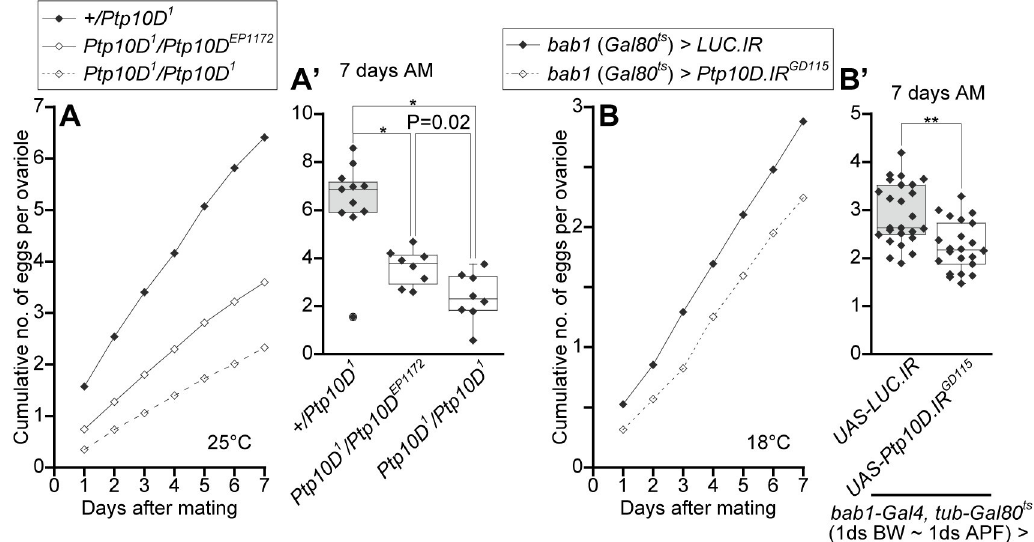
Fig 6. Loss of Ptp10D diminishes the efficient egg production. (A and B) Line graphs represent means of cumulative numbers of eggs per ovarioles laid by single females after mating with single wild-type Canton-S males. (A) Data values from control +/Ptp10D 1 (black line and closed dots in A), Ptp10D 1 /Ptp10D EP1172 (black line and open dots in A), and Ptp10D 1 /Ptp10D 1 (dashed line and open dots in A) at 25 degrees. (B) Data values from control UAS-LUC . IR (black line and closed dots in B) and UAS-Ptp10D . IR (dashed line and open dots in B) by bab1-Gal4 /TARGET at 18 degrees. (A’ and B’) Boxplots overlaid with beeswarm plots representing row data value of 7 days after mating (AM) in (A and B). P-values ( ** P < 0.001, * P < 0.01) for Mann-Whitney U test are shown.